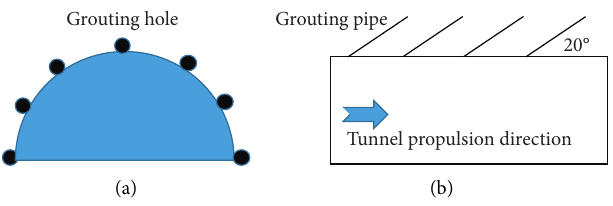
Figure 7: Surrounding rock reinforcement grouting process: (a) front view and (b) side view.